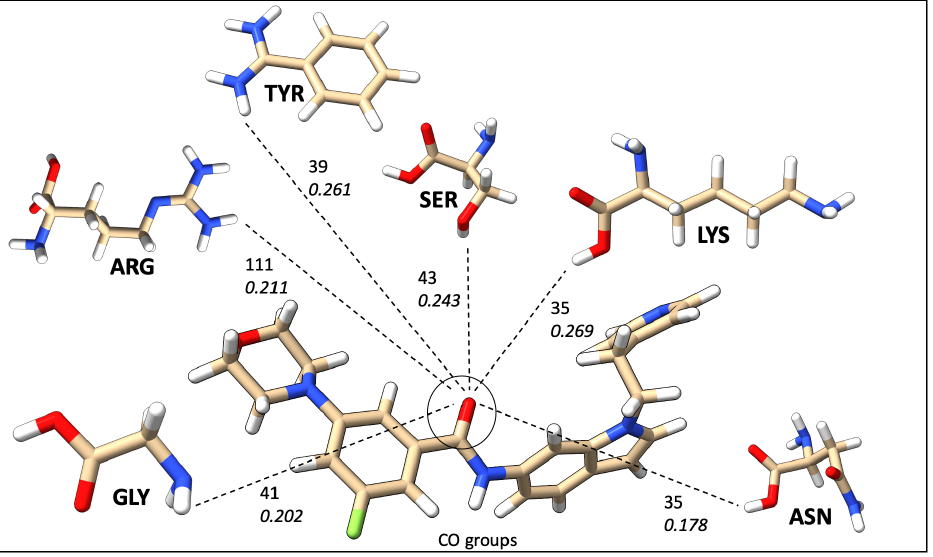
Figure 12. Frequent HBs interactions between the C=O ligand functional group and amino acid residues; the top numerical value mentions the number of HBs, and the bottom value represents the average strength in mDyn/Å from database